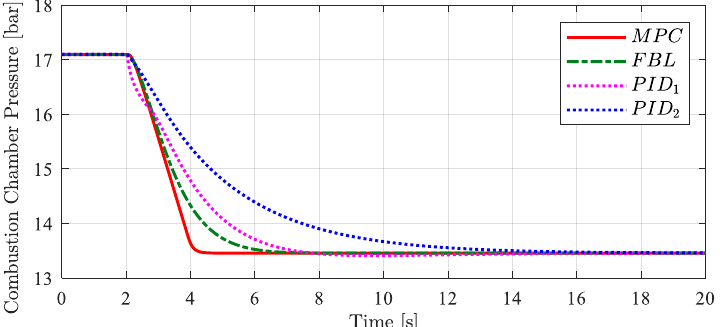
Figure 12. CCP time profile.